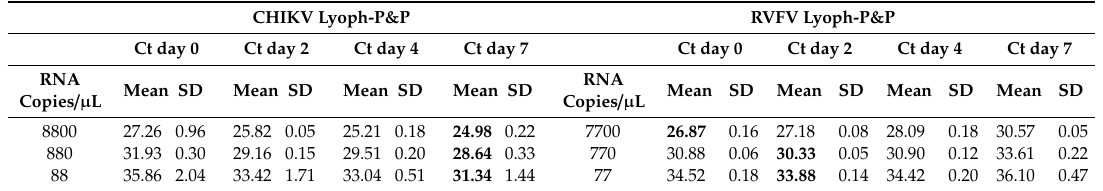
Table 6. Stability of Lyoph-P&P at 37 ◦ C for shipping